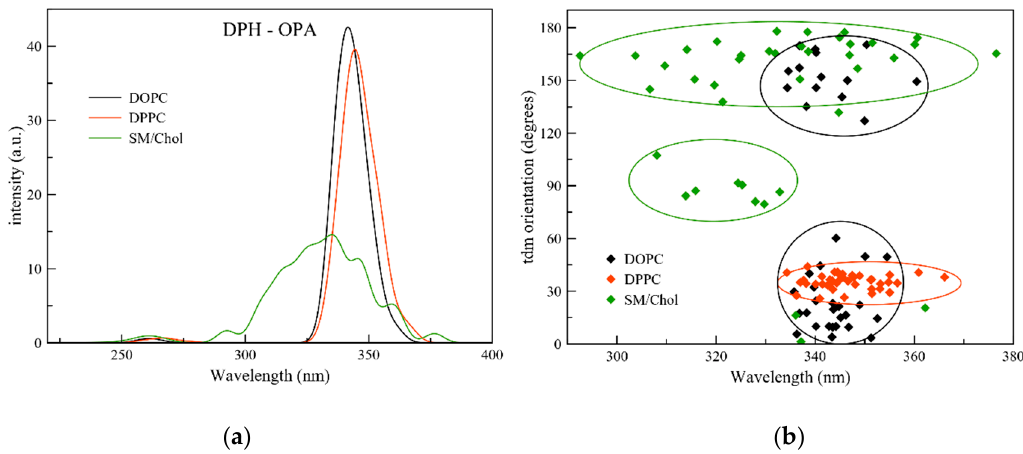
Figure 2. ( a ) One photon absorption spectra of DPH in the three different membranes; ( b ) Correlation between absorption wavelength and orientation of the transition dipole moment (tdm) of the extracted snapshots of DPH in the different membranes.